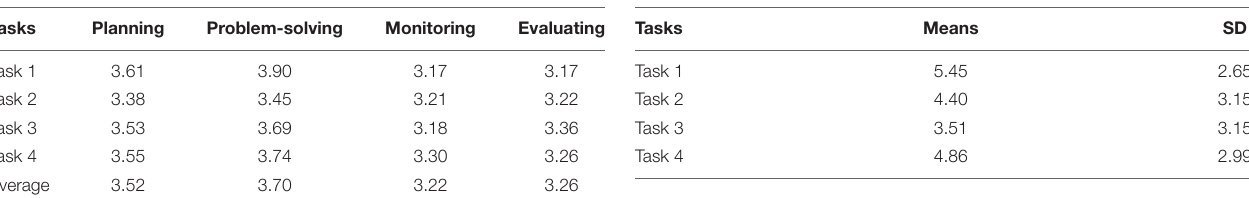
TABLE 2 | Means of individual metacognitive strategies across tasks. TABLE 3 | Descriptive analysis of oral scores across